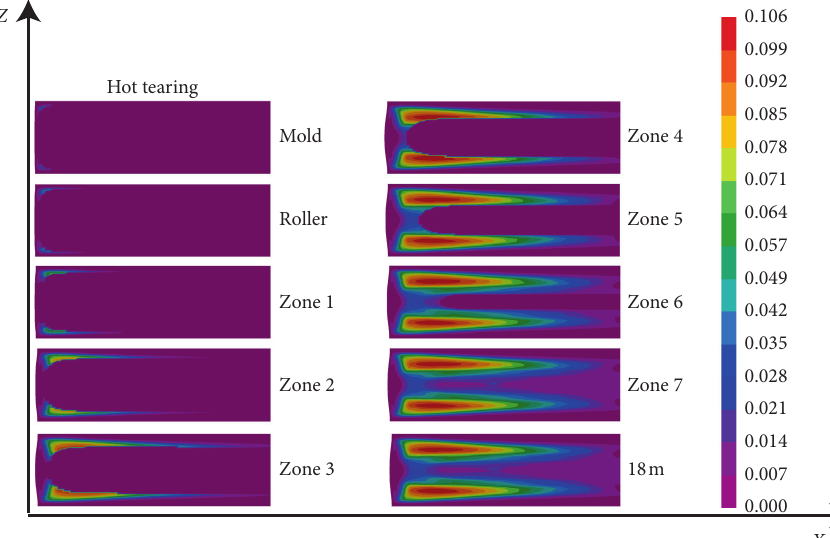
Figure 11: Hot-tearing index of the casting slab at cross